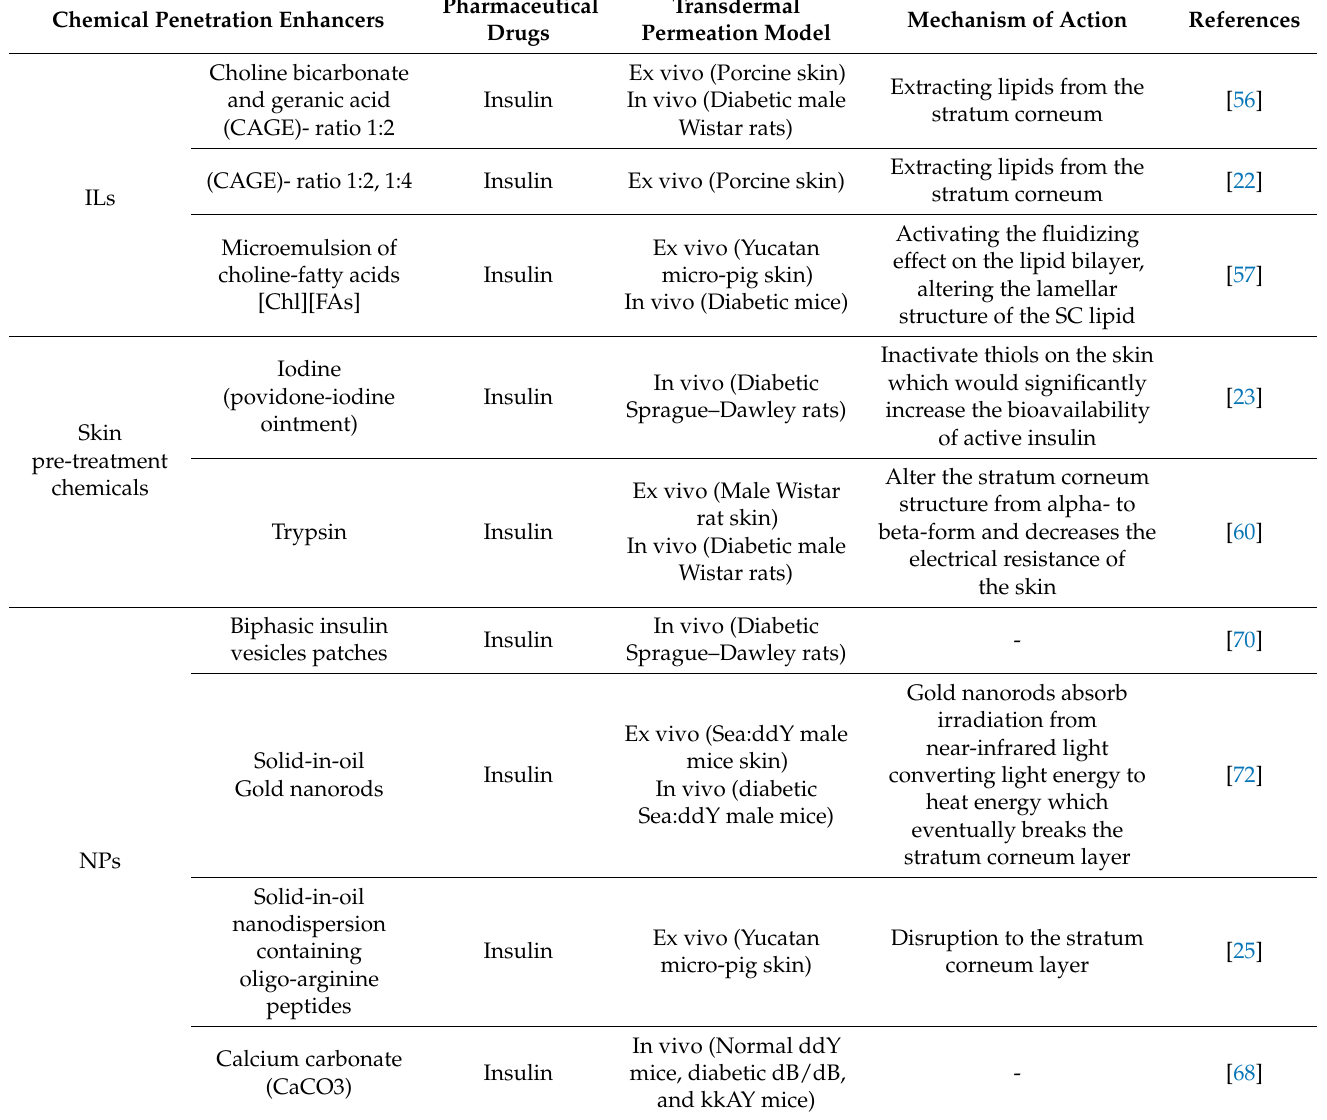
Table 2. Examples of chemical penetration enhancers used for the delivery of insulin and other pharmaceutical drugs, with the possible mechanism of action